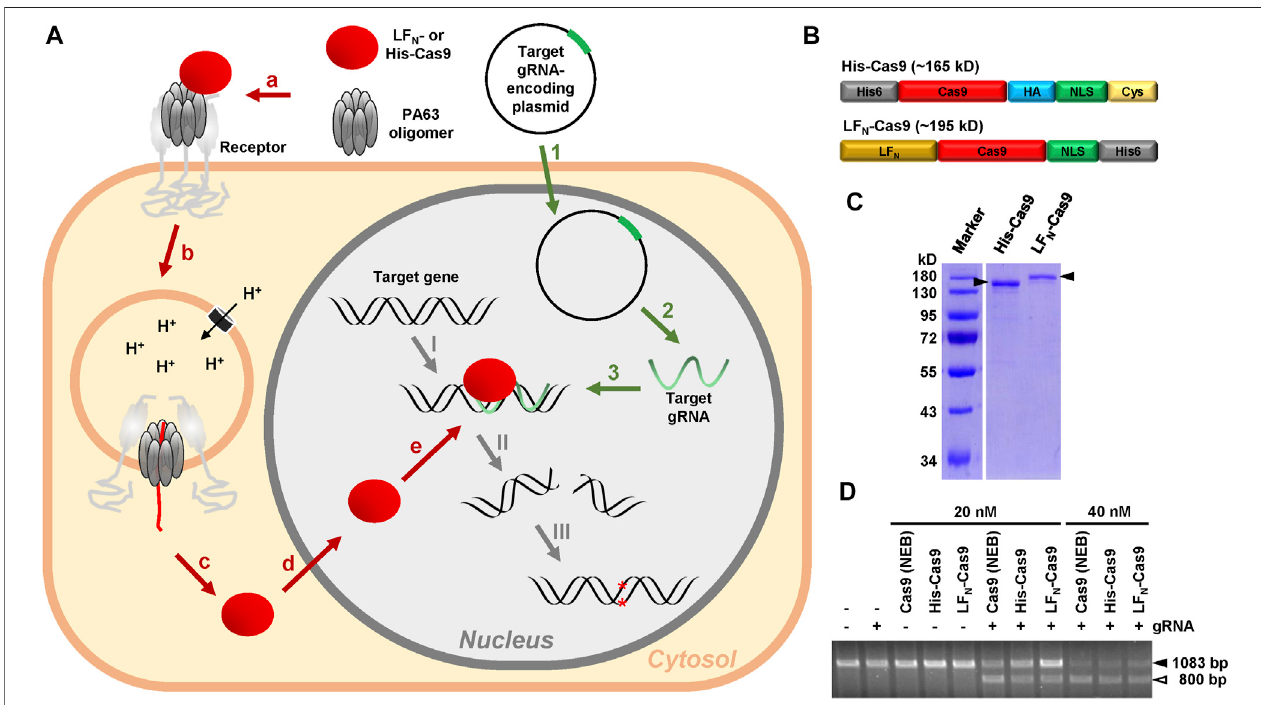
FIGURE 1 | Rationale of the modular CRISPA concept and characterization of His- and LF N -Cas9. (A) 1: A plasmid for the expression of the target gRNA is introduced into cells via transfection; 2: Target gRNA isexpressed by the cells; 3: Target gRNA forms aRNA-DNA-heteroduplexat its target position within the genomic DNA;a:PA63bindsasoligomer toitsreceptoronthecellsurfaceandformsacomplexwithLF N -orHis-Cas9;b:Receptor-mediatedendocytosispromotesentryofthe PA63oligomer – LF N -/His-Cas9 – receptorcomplexintocellsviaendosomes; c:Acidi fi cationoftheendosomesleadstochannelformationofthePA63oligomerinto the endosomal membrane and translocation of unfolded LF N -/His-Cas9 into the cytosol; d: The nuclear localization signal (NLS) promotes entry of refolded LF N -/His- Cas9 into the nucleus; e: LF N -/His-Cas9 is recruited to the RNA-DNA-heteroduplex formed by the gRNA at its target position: I: A LF N -/His-Cas9 – gRNA complex is formed at the target gene. II: LF N -/His-Cas9 leads to a double-strands cleavage of the target gene; III: Non-homologous end joining (NHEJ) generates indels into the target gene, which in turn lead to premature stop codons within the open reading frame (ORF) of the targeted gene, resulting in the knockout of the respective gene (B) Schematic representation of the modular composition of His-Cas9 ( ∼ 165kD) and LF N -Cas9 ( ∼ 195 kD). Please note that the size of the boxes is not related to the size of themodules.His6,hexahistidinetag;HA,humanin fl uenzahemagglutininepitopetag;NLS, nuclearlocalizationsequence; Cys,cysteineresidue (C) Coomassie-stained polyacrylamide gel for size and purity control of puri fi ed His- (0.55 µg) and LF N -Cas9 (0.425 µg) indicated by fi lled arrowheads (D) Cas9 cleavage assay. Cleavage of approx.300 ngtargetDNA(1083 bp; fi lledarrowhead)afterincubationwith20 nMor40 nMHis-orLF N -Cas9,respectively,orcommercialCas9(Cas9(NEB))aloneorin combination with the respective guide RNA (gRNA) was monitored by agarose gel electrophoresis. The open arrowhead indicates the 800 bp cleavage product of the target DNA. bp, base pairs.